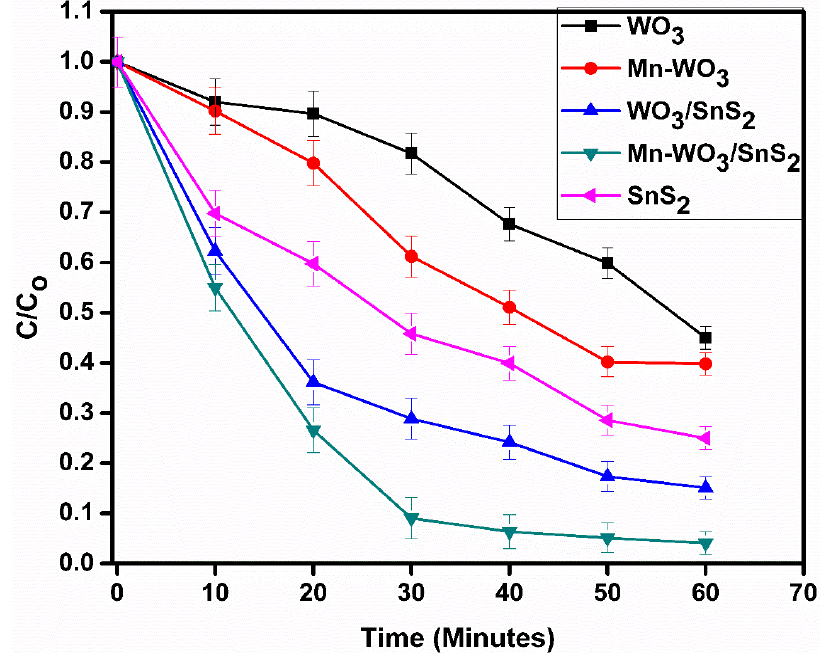
Figure 9. Degradation of chlorpyrifos (1000 ppb) using different photocatalysts at pH = 5 and 0.1 g of photocatalyst.